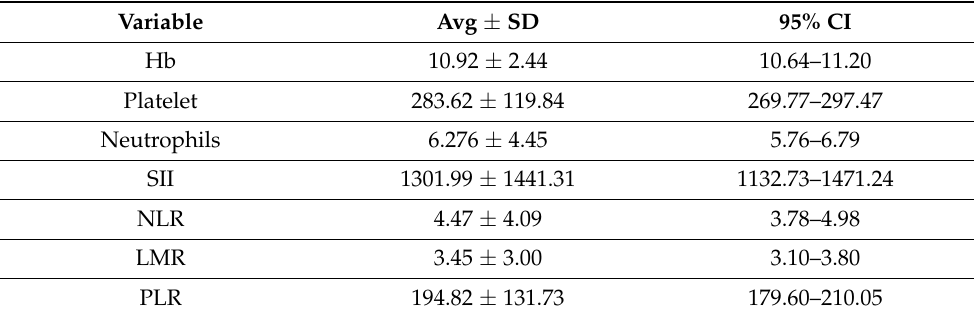
Table 2. Preoperative biological characteristics of the enrolled patients.